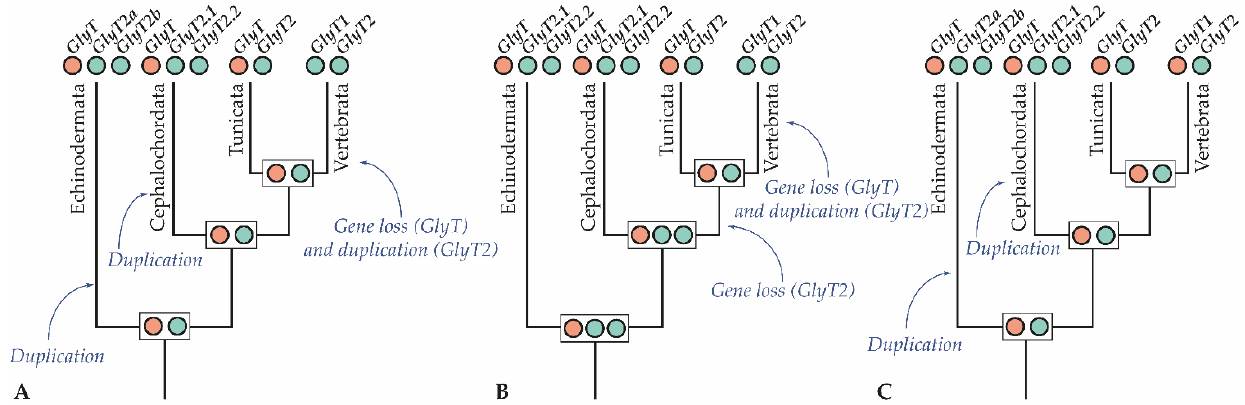
Figure 8. ( A – C ) Competing scenarios for the evolution of glycine transporter genes in deuterostomes. Each circle represents a glycine transporter ( GlyT ) gene. Genes of the same color are orthologs. Boxed circles at internal nodes represent ancestral hypothetical glycine transporter complements.